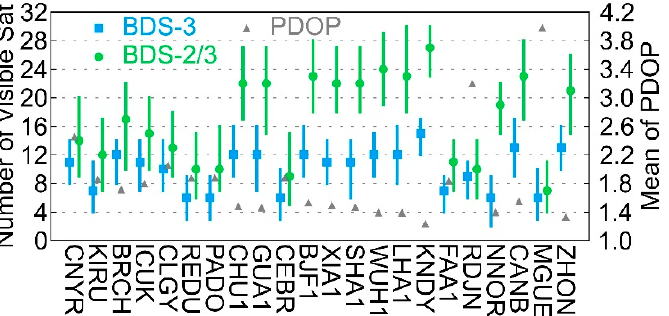
Figure 3. The average numbers of visible BDS-3 (blue square) and BDS-2/3 (green circle) satellites with the vertical lines indicating the corresponding extreme values, as well as the average PDOPs (grey triangle).